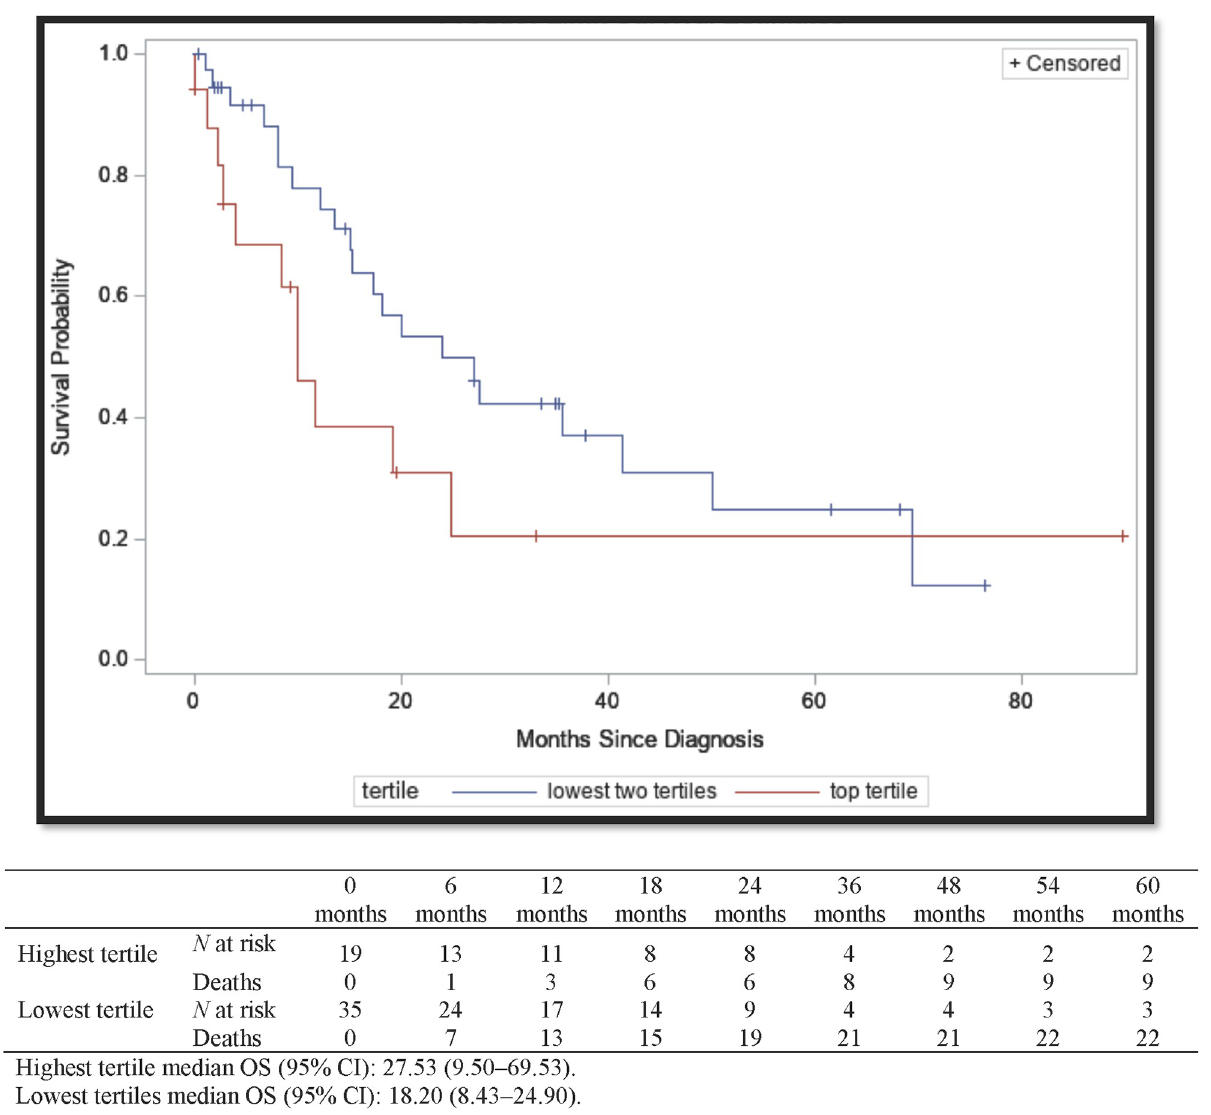
Fig 6. Kaplan-Meier survival curves for overall survival of MBC by highest tertile of IFN- γ signature vs. the lowest two tertiles. Mt Sinai hospital system and North Shore Long Island Jewish health system, New York, New York. 2004–2017. Highest tertile median OS (95% CI): 27.53